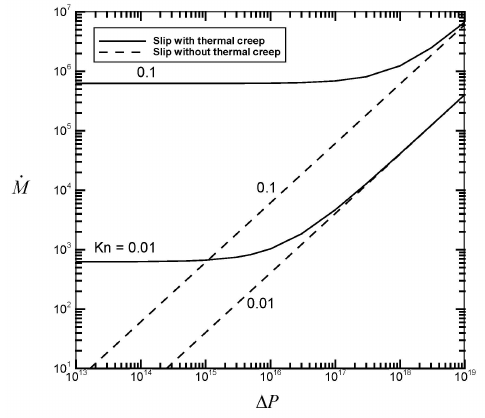
. M versus the dimensionless pressure drop ∆ P for different values of Kn with Figure 3. Flow rate GrL = 10 2 and Ec = 10 ´ 20